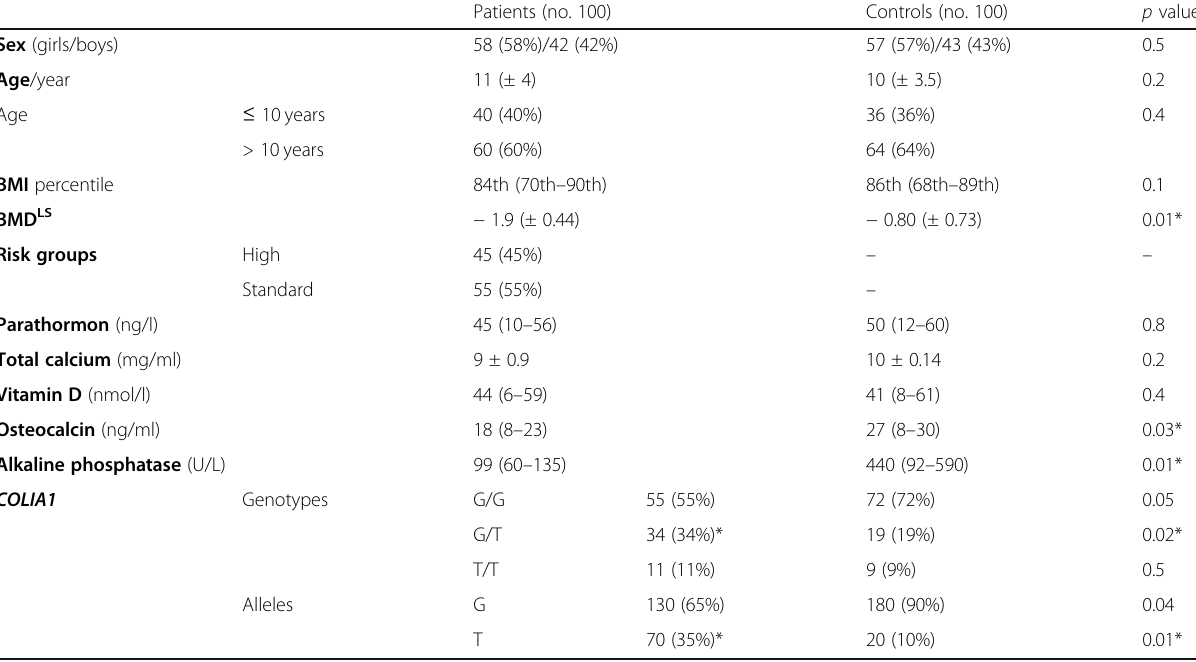
Table 1 Demographic and clinical characteristics of patients and controls at the start of the study (the first assessment) Patients (no.